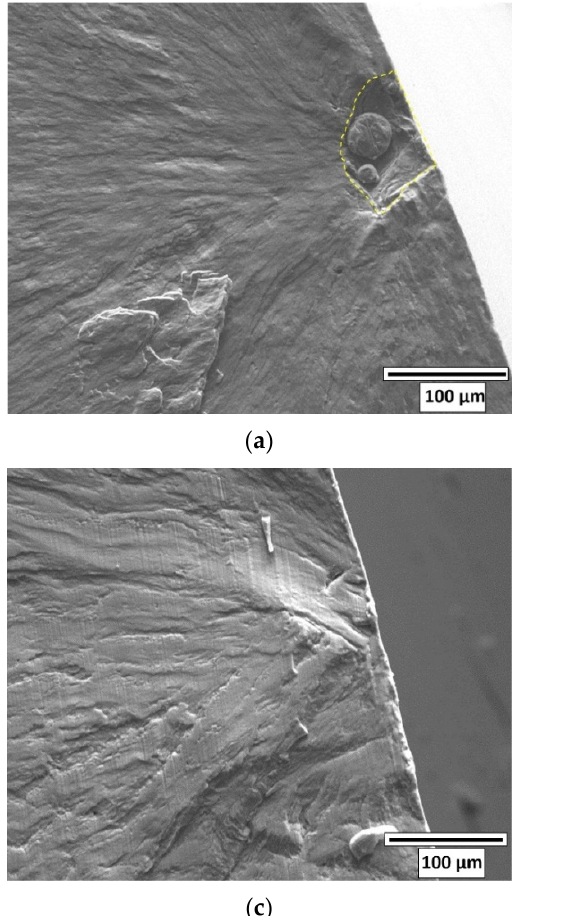
√ area = 104 µ m); ( b ) oxide ( N f = 3.25 × 10 6 cycles);